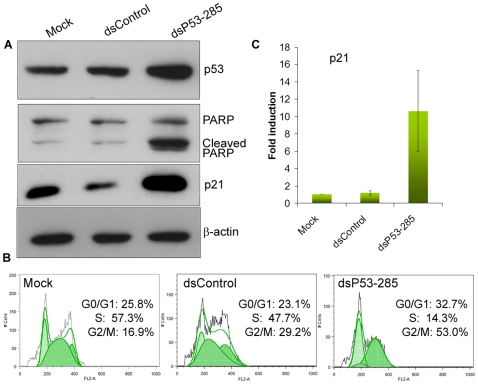
Activation of p53 by saRNA causes cell cycle arrest and induction of p21 in WES cells.
A. WES cells were transfected with 25 nM of the indicated saRNAs for 5 days. Protein levels of p53, PARP and p21 were detected by immunoblot analysis. β-actin served as a loading control. B. WES cells were transfected as in A. Cells were collected, stained with propidium iodide, and processed for analysis by flow cytometry to measure DNA content. Shown are examples of resulting FL2A histograms following analysis with FlowJo software. Cell populations distributed in G0/G1, S, and G2/M phases of the cell cycle are indicated. C. WES cells were transfected with 25 nM of the indicated saRNAs for 72 hrs. p21 mRNA expression was analyzed by real-time PCR. The results represent mean ± SEM of two independent experiments and are plotted as fold induction relative to mock transfections.